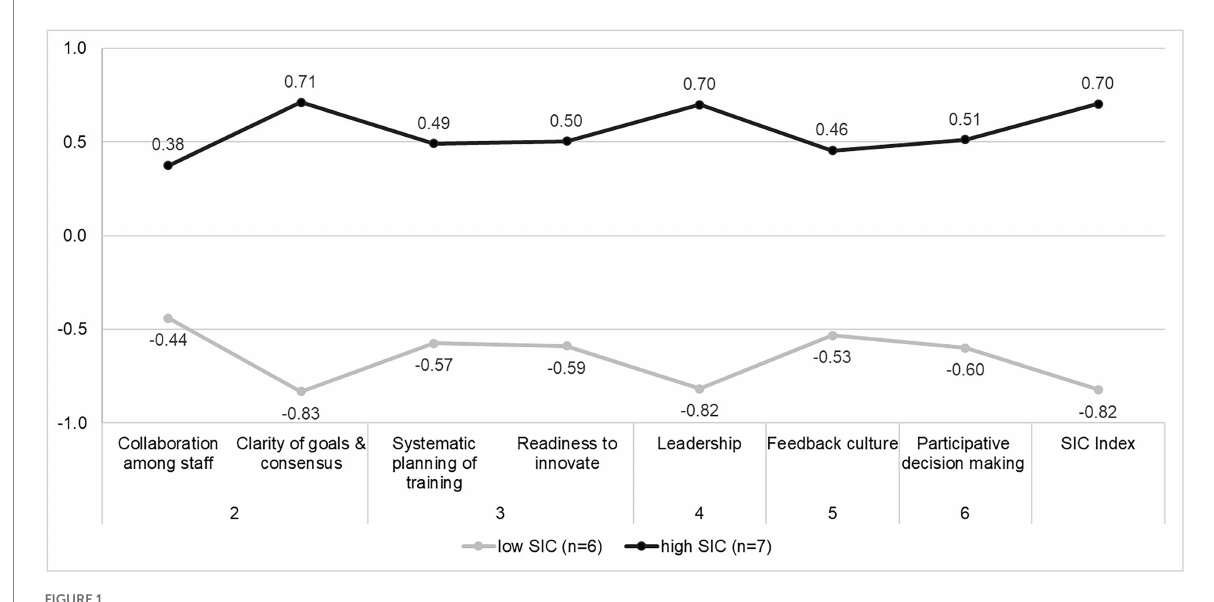
FIGURE 1 Schools’ initial level of SIC , overall (index) and by the separate dimensions of SIC . Standardized values ( M = 0, SD = 1) based on aggregated school